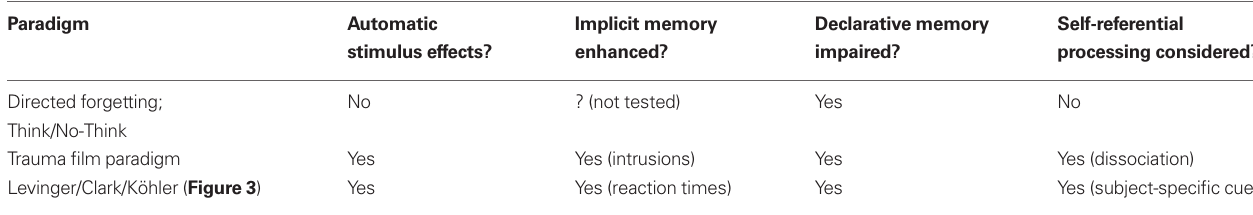
Table 1 | experimental paradigms for studying memory distortions.